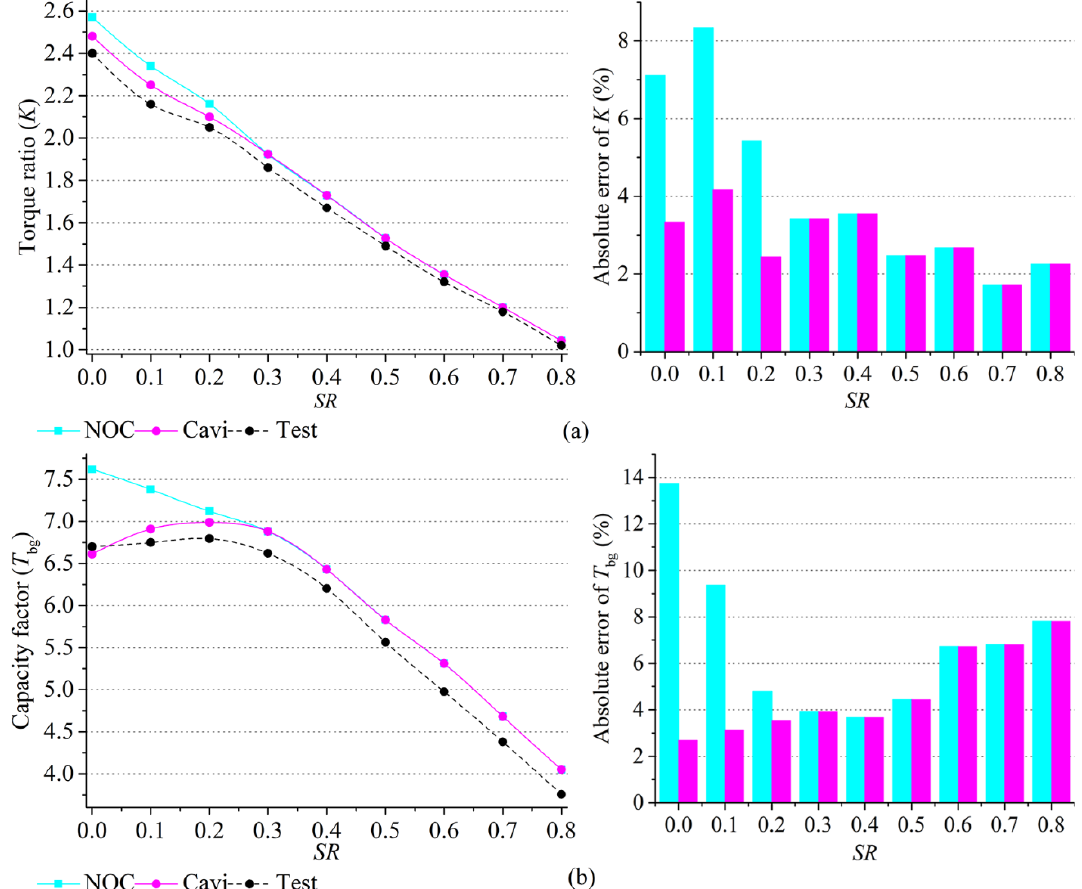
Figure 4. Comparison of CFD results with test data under various SR conditions. ( a ) K and K absolute; ( b ) T bg and T bg absolute error.